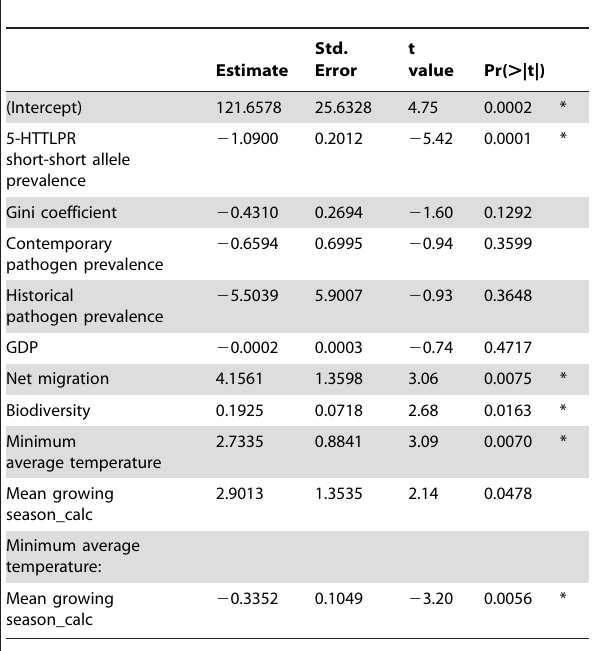
Table 3. Genes, collectivism, migration and ecology.